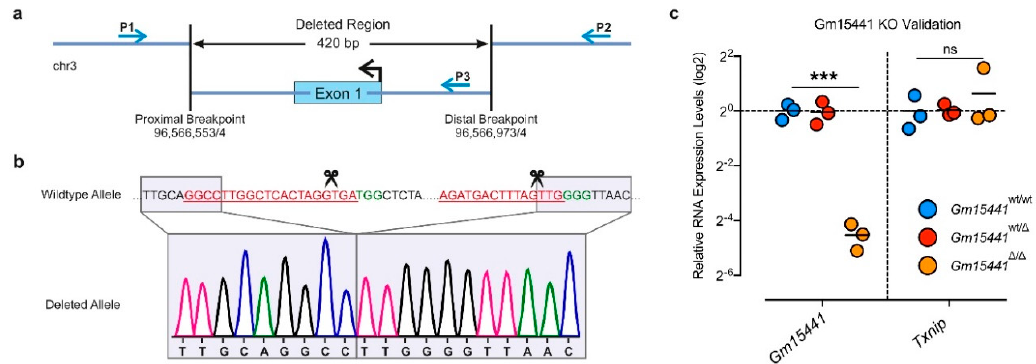
Figure 4. Identification of stable lncRNA-deficient mouse lines: ( a ) Scheme of the genomic locus of founder #1, depicting the Gm15441 ∆ allele with proximal and distal breakpoints. Blue arrows indicate PCR primers P1, P2 and P3 used for genotyping and sequencing. ( b ) Chromatogram showing the genomic DNA sequence of the Gm15441 ∆ allele in comparison to the wildtype allele. ( c ) qPCR gene expression analysis of lncRNA Gm15441 and overlapping protein-coding gene Txnip in mice harboring wildtype ( Gm15441 wt/wt ), heterozygous ( Gm15441 wt/ ∆ ) or homozygous ( Gm15441 ∆ / ∆ ) compositions of the Gm15441 ∆ allele ( n = 3). Graphs represent mean expression values with all data points shown. Statistical differences were calculated using unpaired two-tailed t-tests (UP2T-TT). *** p < 0.001; ns, not significant .